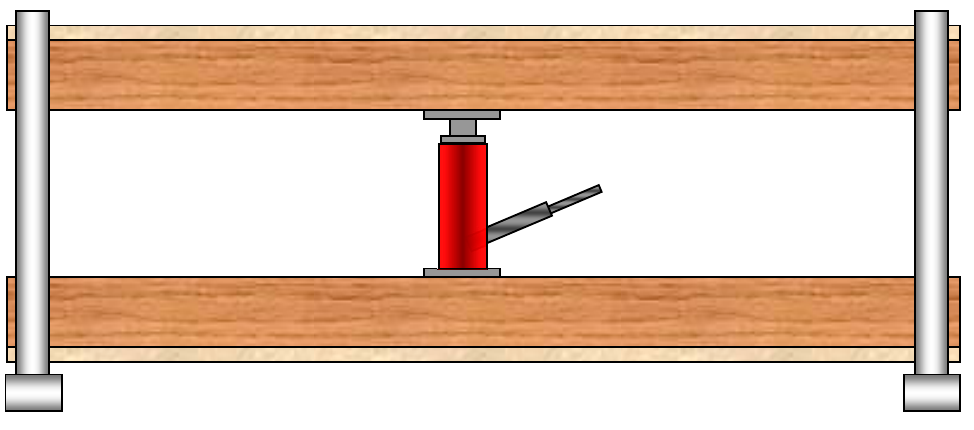
Figure 1. Beam attachment system in the yokes.